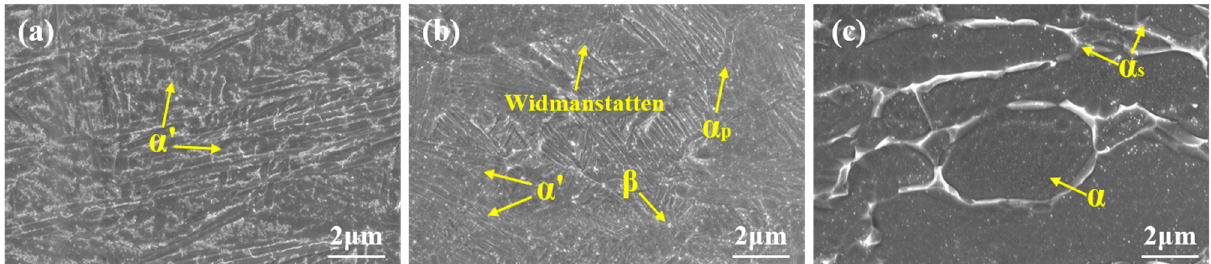
Figure 4. Microstructure of welded joint SEM of ( a ) WM; ( b ) HAZ; ( c ) BM.